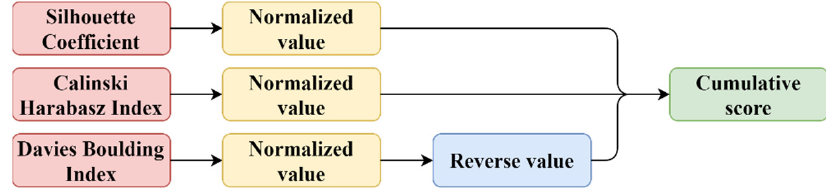
Figure 5. Clustering evaluation methodology.